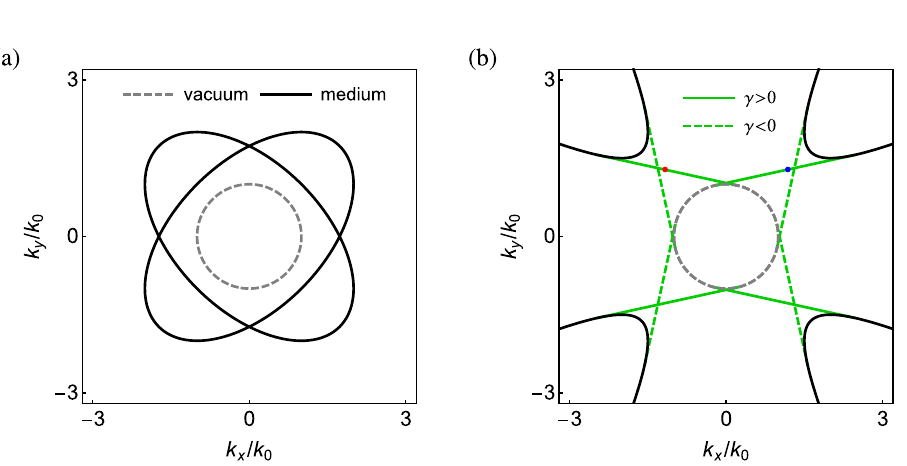
Figure 2. Surface modes at the interface between vacuum and the pseudochiral metamaterial with ( a ) ε n = µ n = 2 and γ = ± 1 ( b ) ε n = µ n = 1.5 and γ = ± 2 ( n = t , z ). Gray dashed contour is dispersion circle of vacuum. Black contours are bulk modes at k z = 0 (cf. Fig. 1). In ( b ), blue and red dots are chosen points for surface wave simulations (cf. Fig.